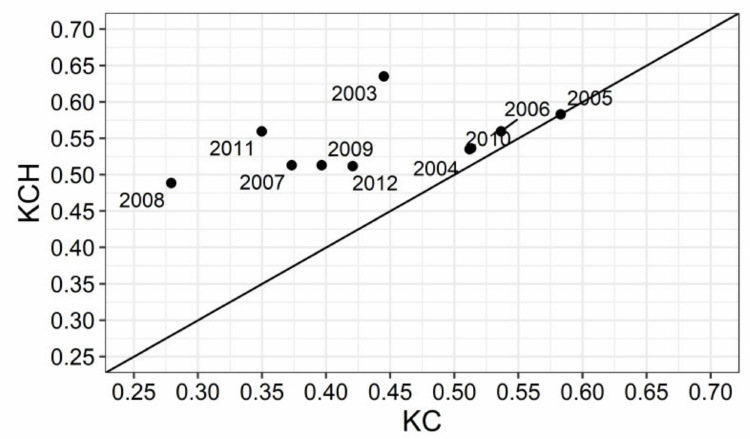
Figure 9. Kolmogorov complexity (KC) and the highest value in the Kolmogorov complexity spectrum (KCH) of the daily H er time-series in Novi